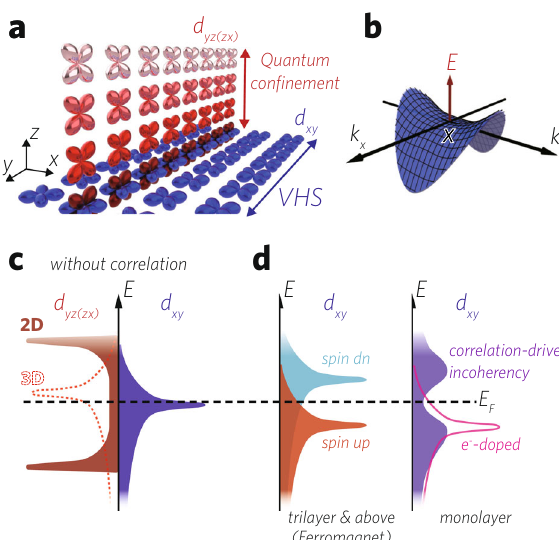
Fig. 4 Interplay between dimensionality, electronic correlation, and magnetism. a, b Schematic illustrations of a quantum con fi nement (QC) effect and b VHS. The out-of-plane orbitals, d yz and d zx , are mainly involved in the QC effect. The in-plane orbital, d xy , is responsible for the high density of states (DOS) at the Fermi level due to the VHS. c , d Schematic illustration of c electronic structures without correlation and d thickness- dependent correlation effect on d xy band. The red dotted line represents the d yz and d zx orbital partial DOS for bulk SRO. The high DOS at the Fermi level from the d xy VHS gives rise to a strong electronic correlation. In thick fi lms (more than 3 uc), the DOS at the Fermi level can be signi fi cantly reduced via ferromagnetic spin splitting. In the monolayer SRO case, the spin splitting is inhibited due to the QC effect. As a result, the d xy DOS at the Fermi level is reduced via opening a soft gap 35 . When VHS is far from the Fermi level, the coherent states can be recovered.